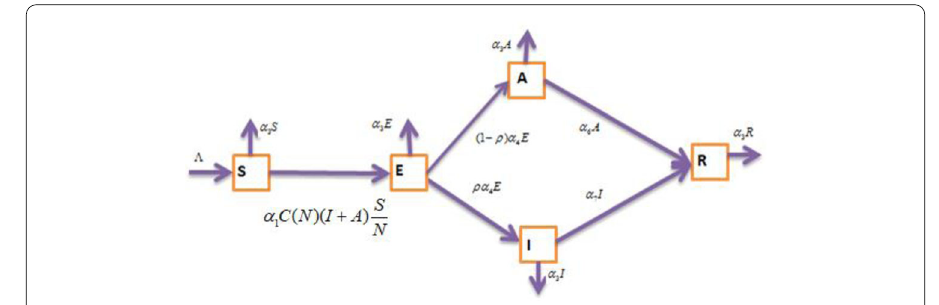
Figure 1 Flow diagram of SEAIR endemic